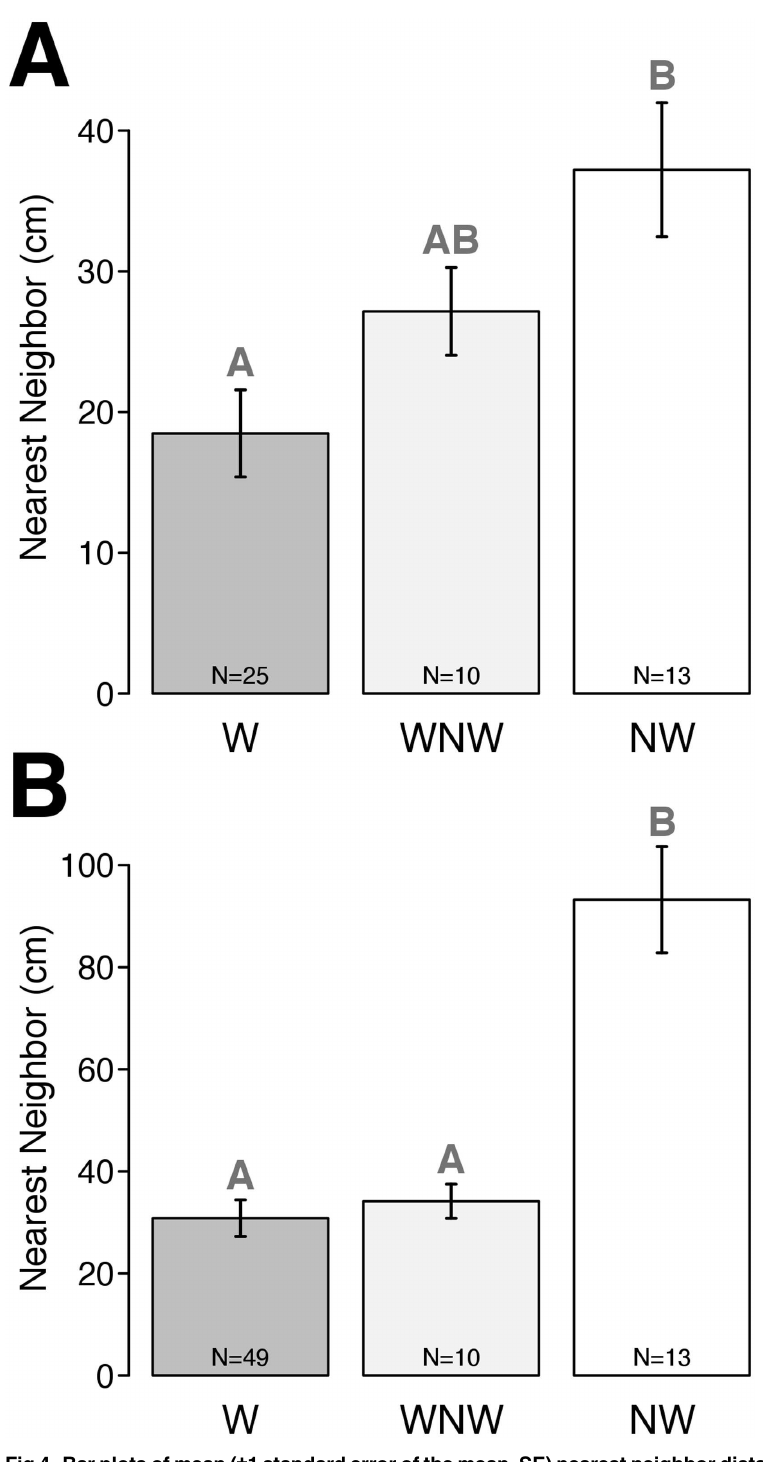
Fig 4. Bar plots of mean ( ± 1standard error of the mean, SE) nearest neighbor distances of Mercenaria mercenaria at East Marion, New York, USA. (A) endo- + epibenthicclams and (B) epibenthic clams only. W = walkingclams, in ‘walking’area; NW = non-walking clams, in ‘non-walking’ area; WNW = non-walking clams in ‘walking’area. Different letters above bars representsignificantly different densitiesat p < 0.05.